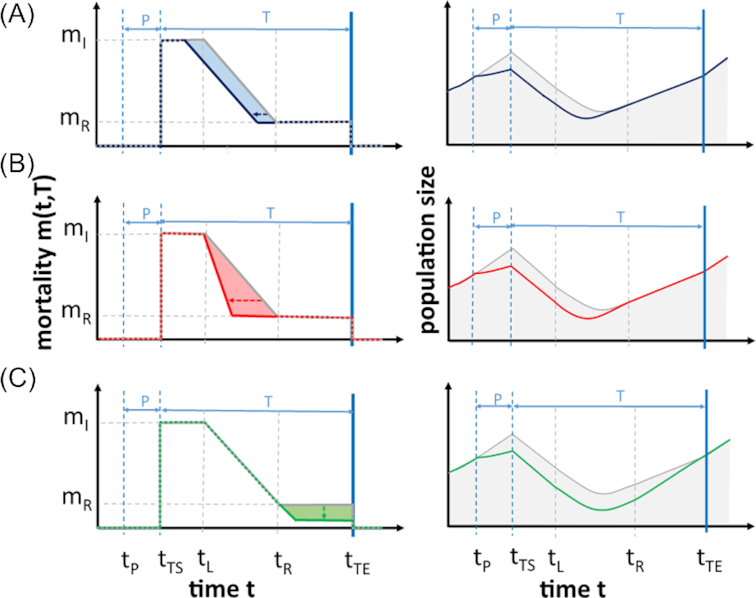
Potential responses of primed and naïve species toward stress impacts on mortality and the resulting population size. Left panels: Mortality of primed and naïve species, having (A) a stronger, (B) an earlier and (C) a faster response. Right panels: the respective population dynamics. In all panels, the naïve stress response is represented by the gray line, and the colored line represents the primed response. Priming costs are not illustrated here, as they do not affect mortality. Abbreviations: \documentclass[12pt]{minimal}
\usepackage{amsmath}
\usepackage{wasysym}
\usepackage{amsfonts}
\usepackage{amssymb}
\usepackage{amsbsy}
\usepackage{upgreek}
\usepackage{mathrsfs}
\setlength{\oddsidemargin}{-69pt}
\begin{document}
}{}$P\ $\end{document} = priming; \documentclass[12pt]{minimal}
\usepackage{amsmath}
\usepackage{wasysym}
\usepackage{amsfonts}
\usepackage{amssymb}
\usepackage{amsbsy}
\usepackage{upgreek}
\usepackage{mathrsfs}
\setlength{\oddsidemargin}{-69pt}
\begin{document}
}{}$T\ $\end{document} = triggering; \documentclass[12pt]{minimal}
\usepackage{amsmath}
\usepackage{wasysym}
\usepackage{amsfonts}
\usepackage{amssymb}
\usepackage{amsbsy}
\usepackage{upgreek}
\usepackage{mathrsfs}
\setlength{\oddsidemargin}{-69pt}
\begin{document}
}{}${m_\mathrm{ I}}$\end{document} = initial mortality; \documentclass[12pt]{minimal}
\usepackage{amsmath}
\usepackage{wasysym}
\usepackage{amsfonts}
\usepackage{amssymb}
\usepackage{amsbsy}
\usepackage{upgreek}
\usepackage{mathrsfs}
\setlength{\oddsidemargin}{-69pt}
\begin{document}
}{}${m_\mathrm{ R}}$\end{document} = final mortality level of the stress response; \documentclass[12pt]{minimal}
\usepackage{amsmath}
\usepackage{wasysym}
\usepackage{amsfonts}
\usepackage{amssymb}
\usepackage{amsbsy}
\usepackage{upgreek}
\usepackage{mathrsfs}
\setlength{\oddsidemargin}{-69pt}
\begin{document}
}{}${t_\mathrm{ P}}$\end{document} = beginning of the priming phase; \documentclass[12pt]{minimal}
\usepackage{amsmath}
\usepackage{wasysym}
\usepackage{amsfonts}
\usepackage{amssymb}
\usepackage{amsbsy}
\usepackage{upgreek}
\usepackage{mathrsfs}
\setlength{\oddsidemargin}{-69pt}
\begin{document}
}{}${t_{\mathrm{ TS}}}$\end{document} = beginning of the triggering stress; \documentclass[12pt]{minimal}
\usepackage{amsmath}
\usepackage{wasysym}
\usepackage{amsfonts}
\usepackage{amssymb}
\usepackage{amsbsy}
\usepackage{upgreek}
\usepackage{mathrsfs}
\setlength{\oddsidemargin}{-69pt}
\begin{document}
}{}${t_\mathrm{ L}}$\end{document} = end of the response lag phase; \documentclass[12pt]{minimal}
\usepackage{amsmath}
\usepackage{wasysym}
\usepackage{amsfonts}
\usepackage{amssymb}
\usepackage{amsbsy}
\usepackage{upgreek}
\usepackage{mathrsfs}
\setlength{\oddsidemargin}{-69pt}
\begin{document}
}{}${t_\mathrm{ R}}$\end{document} = time point when \documentclass[12pt]{minimal}
\usepackage{amsmath}
\usepackage{wasysym}
\usepackage{amsfonts}
\usepackage{amssymb}
\usepackage{amsbsy}
\usepackage{upgreek}
\usepackage{mathrsfs}
\setlength{\oddsidemargin}{-69pt}
\begin{document}
}{}${m_\mathrm{ R}}$\end{document} has been reached; \documentclass[12pt]{minimal}
\usepackage{amsmath}
\usepackage{wasysym}
\usepackage{amsfonts}
\usepackage{amssymb}
\usepackage{amsbsy}
\usepackage{upgreek}
\usepackage{mathrsfs}
\setlength{\oddsidemargin}{-69pt}
\begin{document}
}{}${t_{\mathrm{ TE}}}$\end{document} = end of triggering stress.